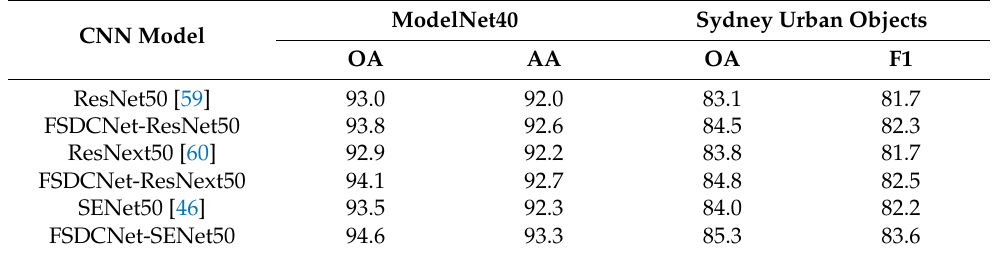
Table 5. Comparison of classification performance between static and dynamic convolution.